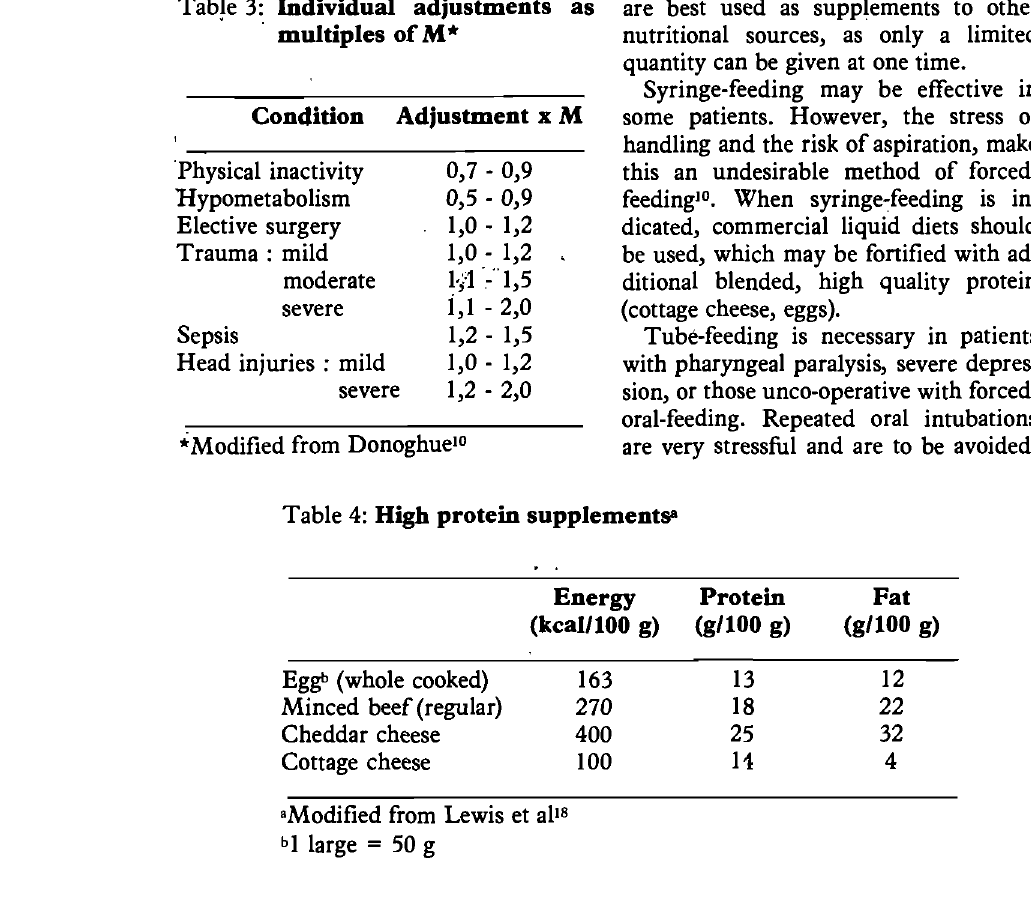
Table 4: High protein